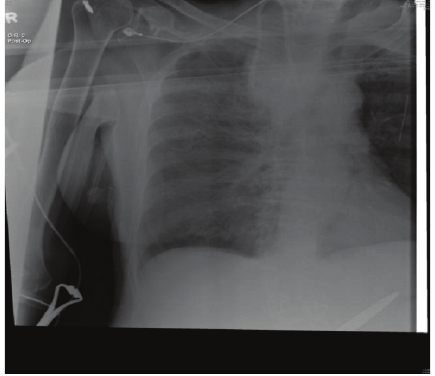
Figure 2: Chest X-ray showing right upper lobe whitening.